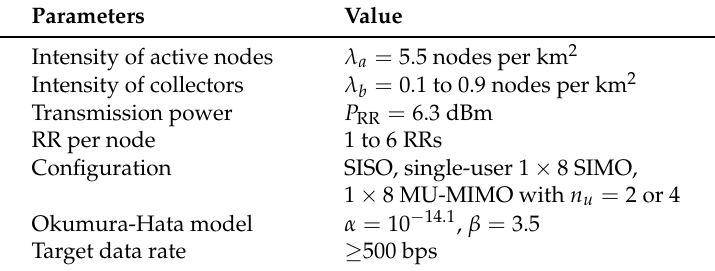
Table 1. Network